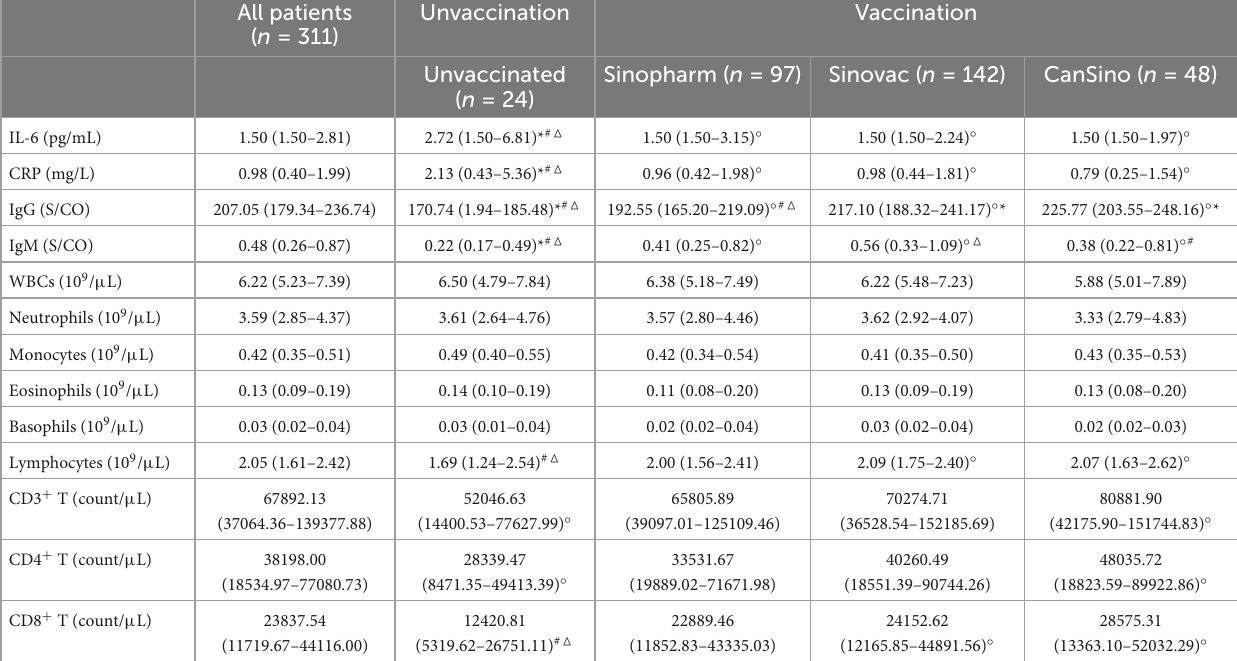
TABLE 5 The immune-related indicators of convalescent adult patients in different groups of patients. All patients ( n =